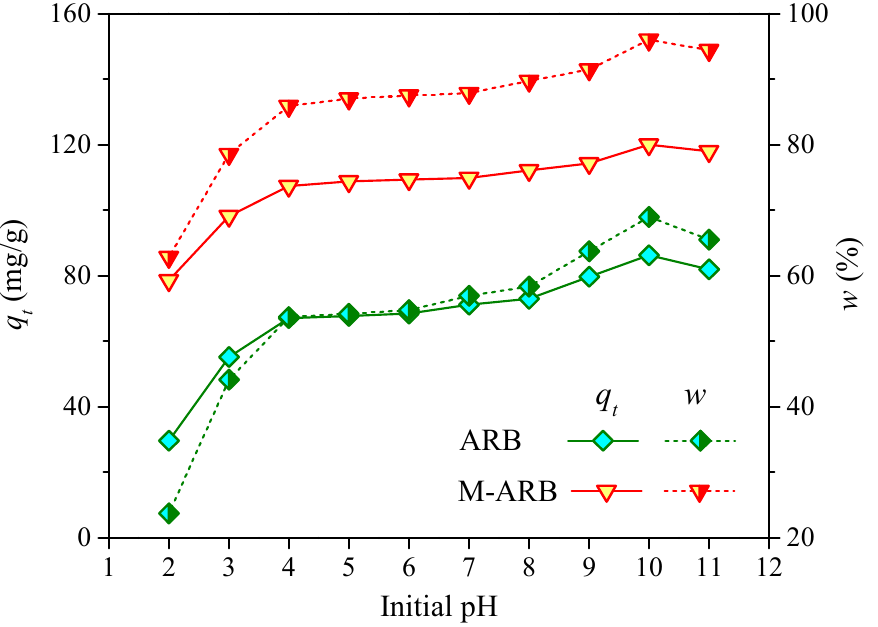
Figure 3. Effect of initial pH on MB adsorption performance.